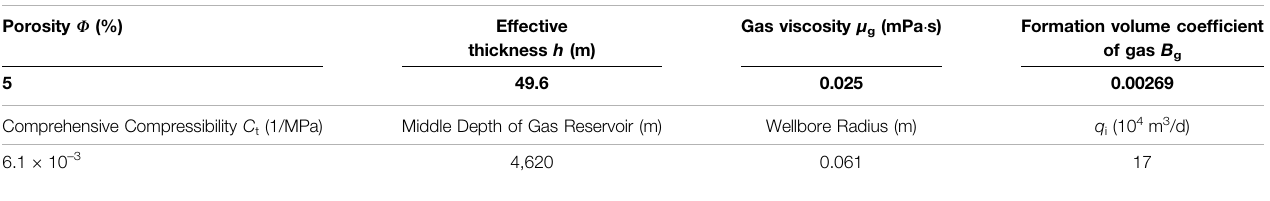
TABLE 1 | Basic parameters of Well